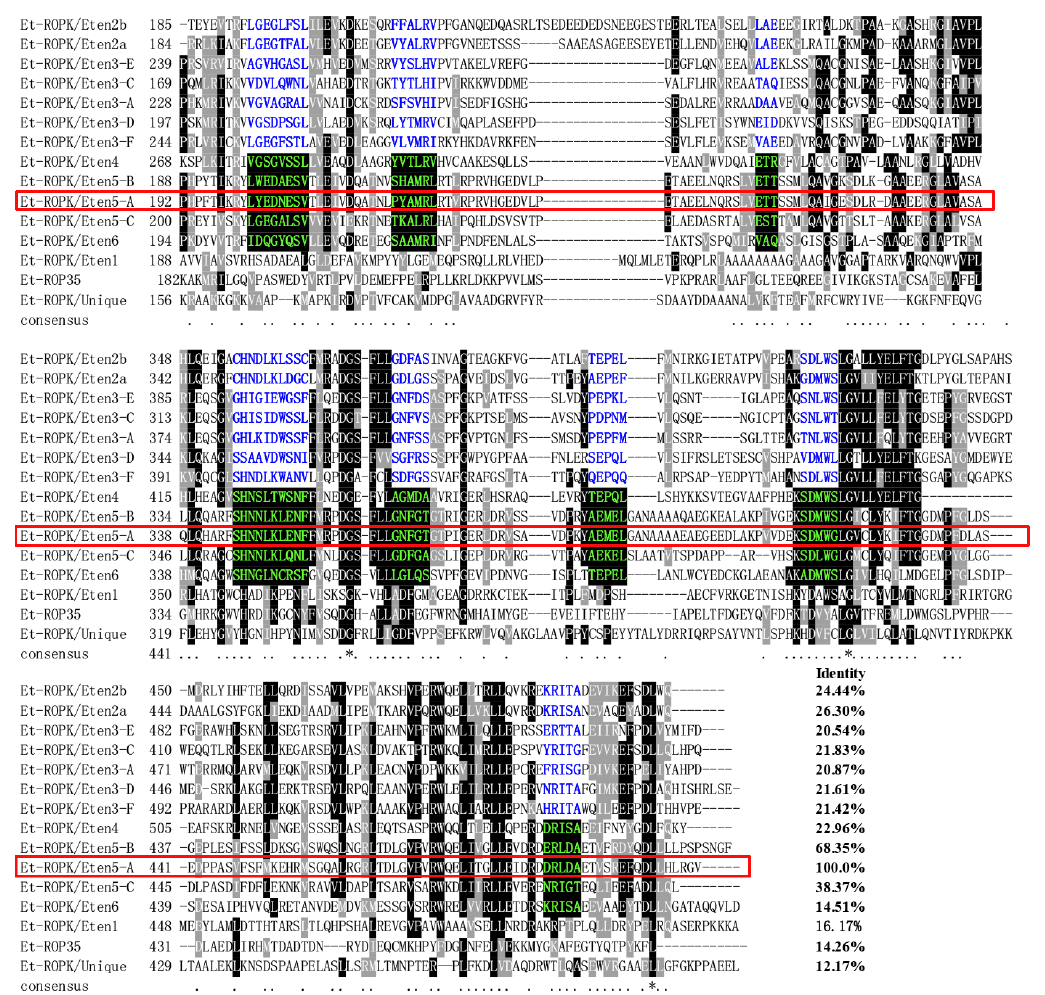
Figure 4. Sequence alignment and conserved motif analysis of E. tenella rhoptries (ROP) proteins. Multiple sequence alignment was performed using Clustal X software version 1.83. The regions of high identity and similarity between ROP sequences are shown as black and gray columns, respectively. The identity of Et-ROPK-Eten5-A with each ROP is shown at the end of the alignment. The conserved motif regions of the kinase domain are highlighted. The conserved motifs of predicted noncanonical catalytic mechanisms are highlighted with blue letters. The conserved motifs of likely inactive rhoptry kinase subfamilies are highlighted with a black background and green letters. The catalytic activities of the conserved motifs were predicted in a previous report [32]. TheEt-ROPK-Eten5-A in this study is circled in red frame.